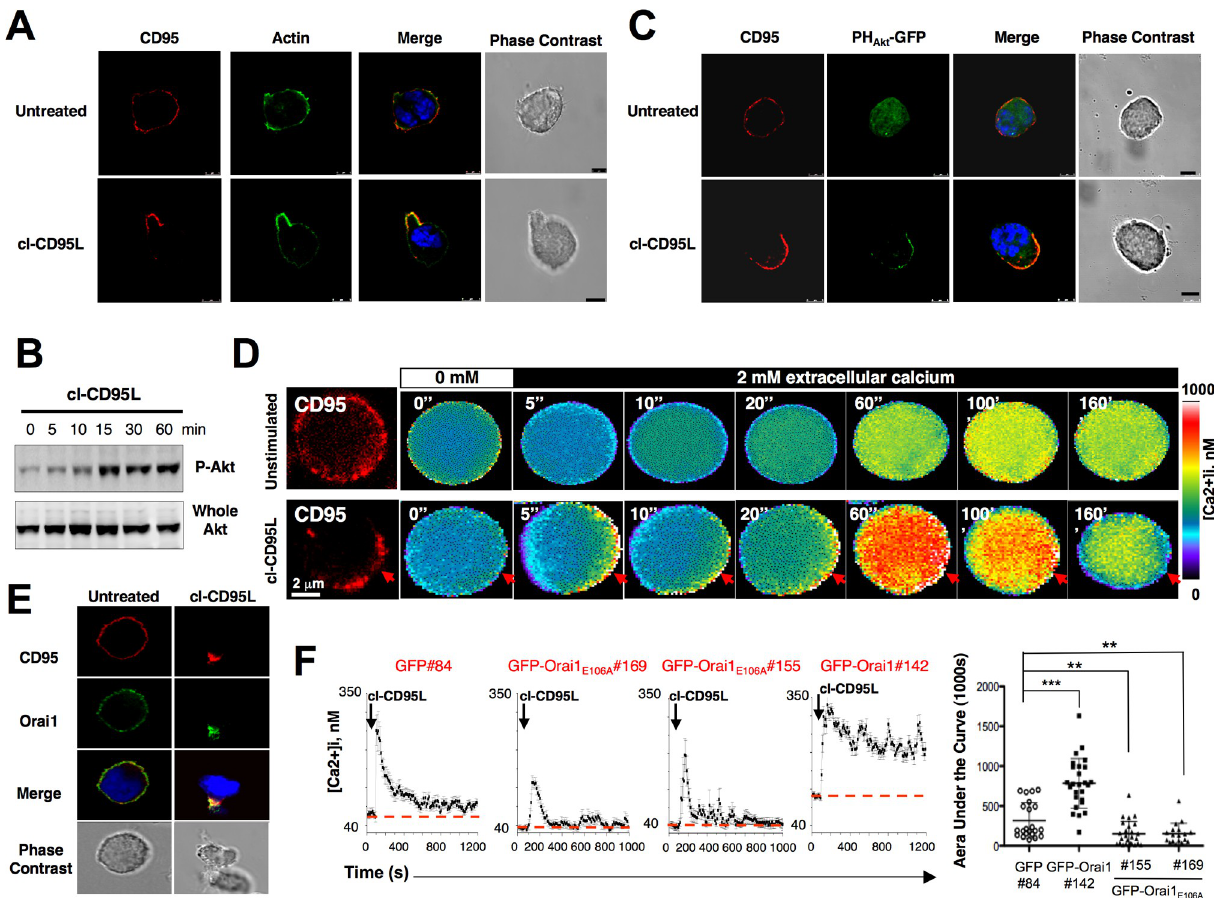
Fig 2. Cleaved CD95L triggers a pseudopod-localized actin/PI3K/Akt signal and a Ca 2+ entry through activation of the CRAC channel Orai1. (A) H9 T-cells were transiently transfected with the actin marker Lifeact-GFP. Living cells were harvested (Ficoll) and treated for 30 min with 100 ng/ml of cleaved CD95L or with control medium (supernatant of pcDNA3.1(+)-transfected HEK cells—untreated). Cells were fixed, and CD95 was stained using anti-CD95 mAb (APO1-3) and revealed with the secondary Alexa555-coupled Goat anti-mouse antibody (red). Nuclei were stained using DAPI (blue). Bars = 5 mm. Images were acquired with an ApoPLAN 63 × objective. (B) The leukemic T-cell line H9 was incubated with 100 ng/ml of the naturally processed CD95L for indicated times. Cells were lysed, and for each lane, 100 mg of protein were loaded. Proteins were resolved by SDS-PAGE and anti- whole Akt and anti-Akt phosphorylation (serine 473 ) immunoblots were performed. Akt phosphorylation stands for its activation. (C) The pleckstrin homology (PH) domain of Akt binds PIP3 produced by PI3K activation. As a consequence, the probe PH Akt -GFP stains PIP3. H9 T-cells were